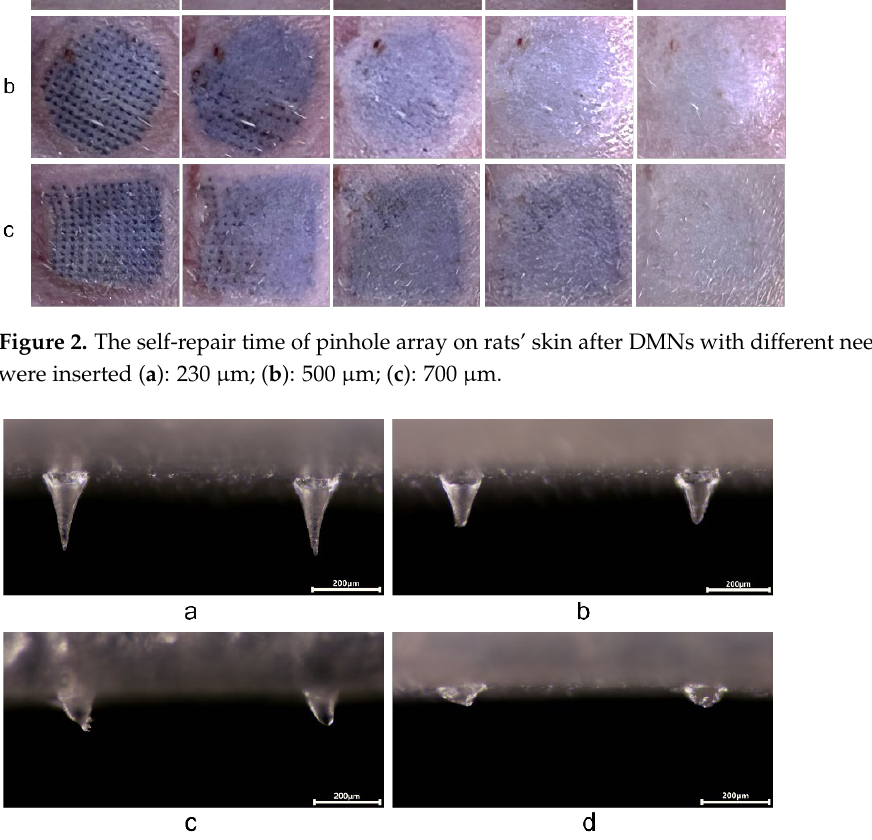
Figure 3. Microscopy images of morphological changes in CP-DMNs before ( a ) and after insertion into ex vivo suckling pig skin for 20 s, and maintained for 0 ( b ), 10 ( c ), 30 ( d ) min (scale bar is 200 μm).